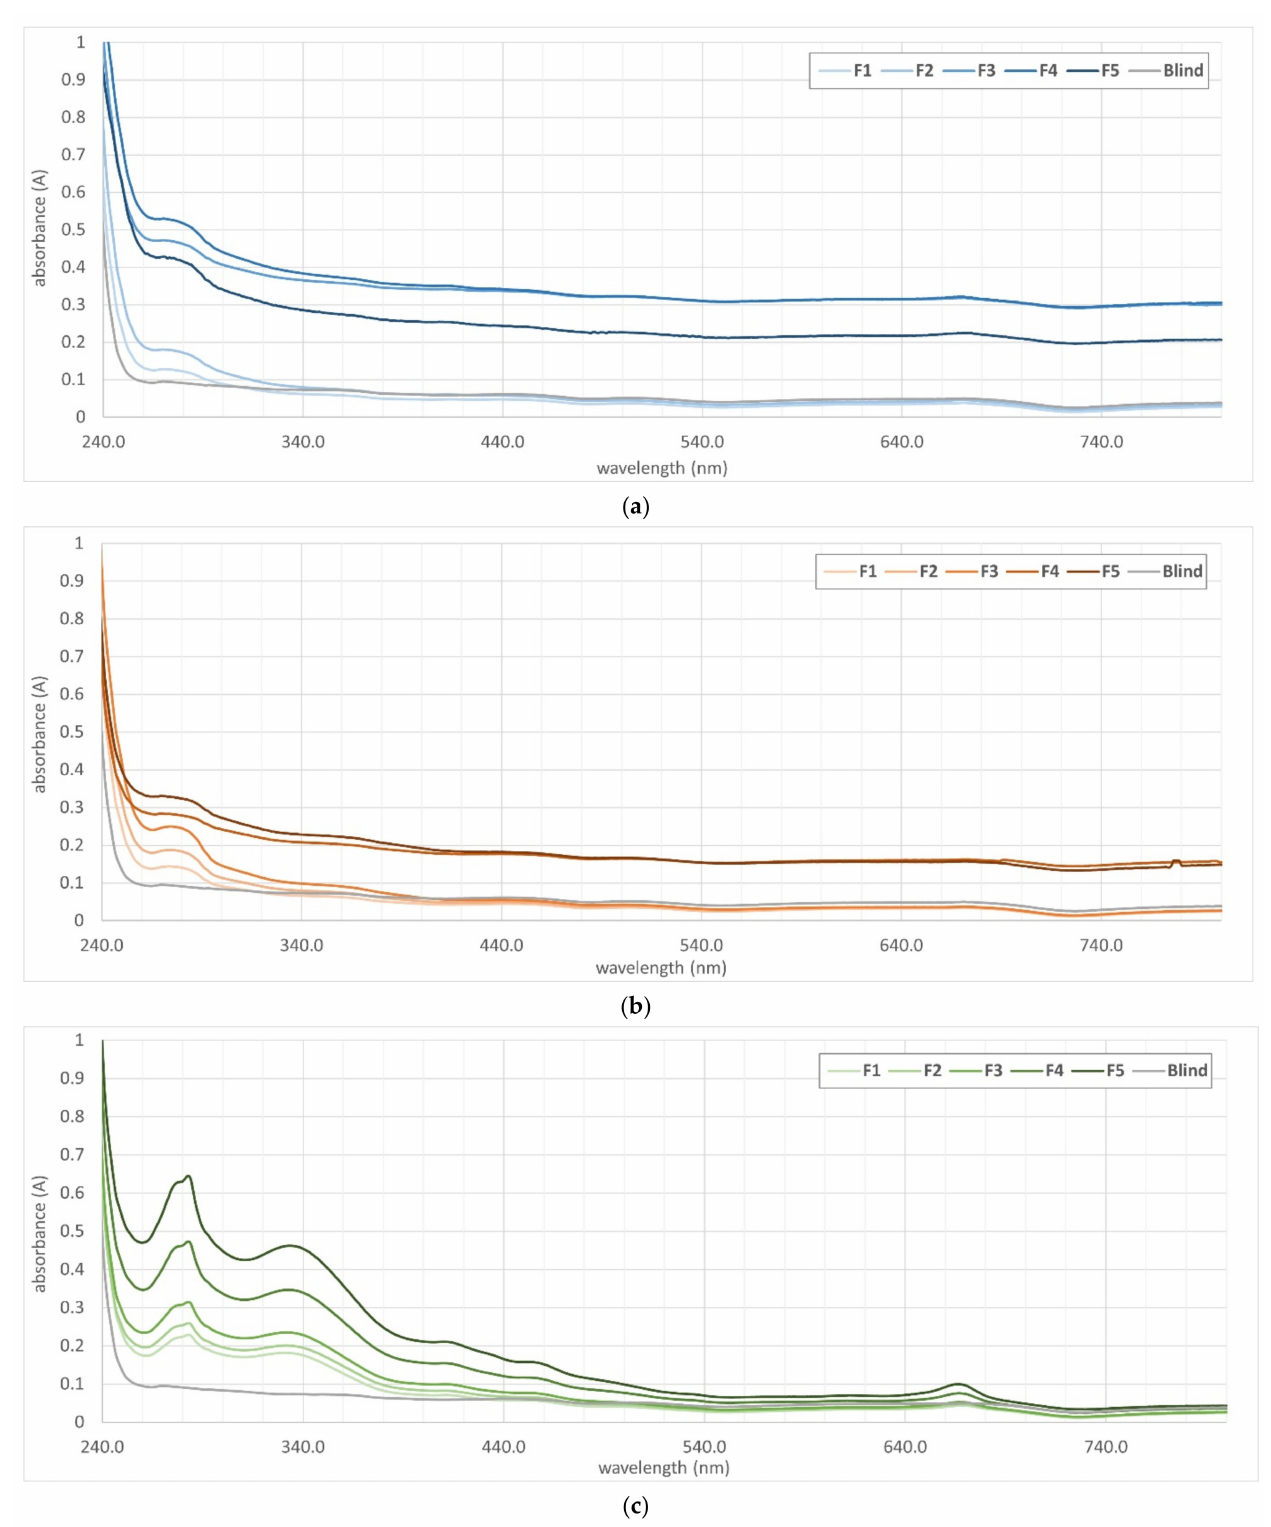
Figure 1. UV/Vis absorbance spectra of three different plant-based extracts. Ninefold determination (three films with three measurements conducted at random locations of each film). ( a ): Abies nordmanniana (AN) extract; ( b ): Aesculus hippocastanum (AEH) extract; ( c ): Thymus vulgaris (TV)